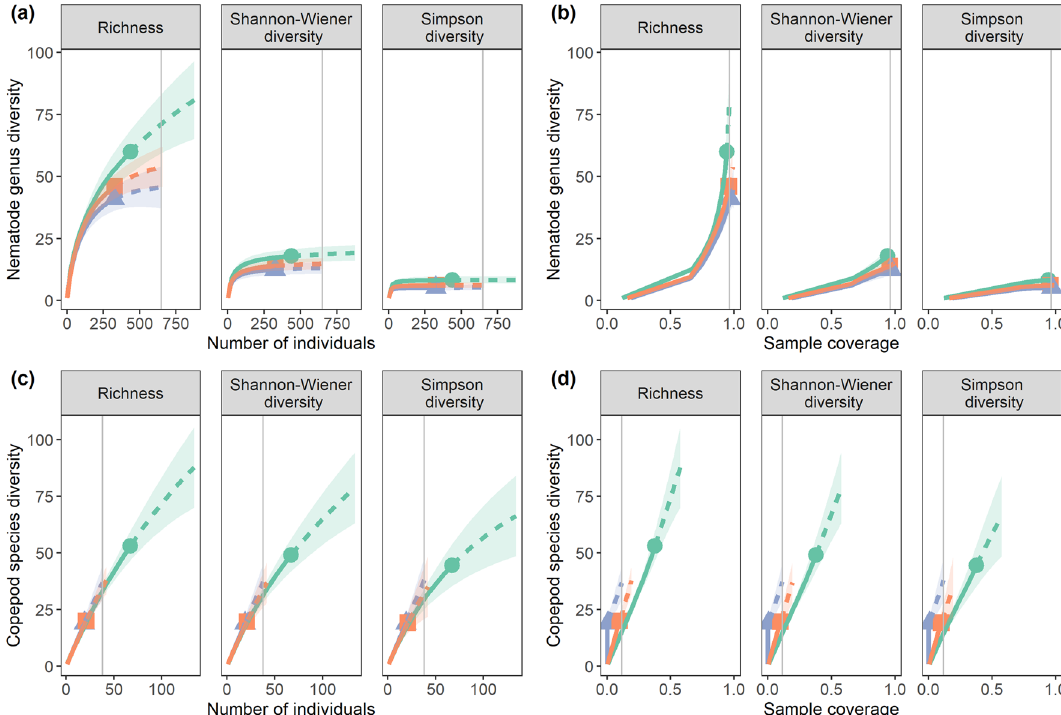
Figure 3. Nematode and copepod diversity at the nodule-free (NodFree) and nodule-rich (NodRich_A and NodRich_B) stations. Shown are sample-size (left) and sample coverage-based (right) rarefaction (interpolated) and extrapolation (predicted, guided by asymptotic estimators) curves for ( a , b ) nematode genus and ( c , d ) copepod species diversity, based on abundances. The different panels show Hill numbers of orders (q) 0 (Richness), 1 (Shannon–Wiener diversity) and 2 (Simpson diversity). The vertical grey line denotes the base sample size (left) or the base sample coverage (right). Shaded areas represent 95% confidence